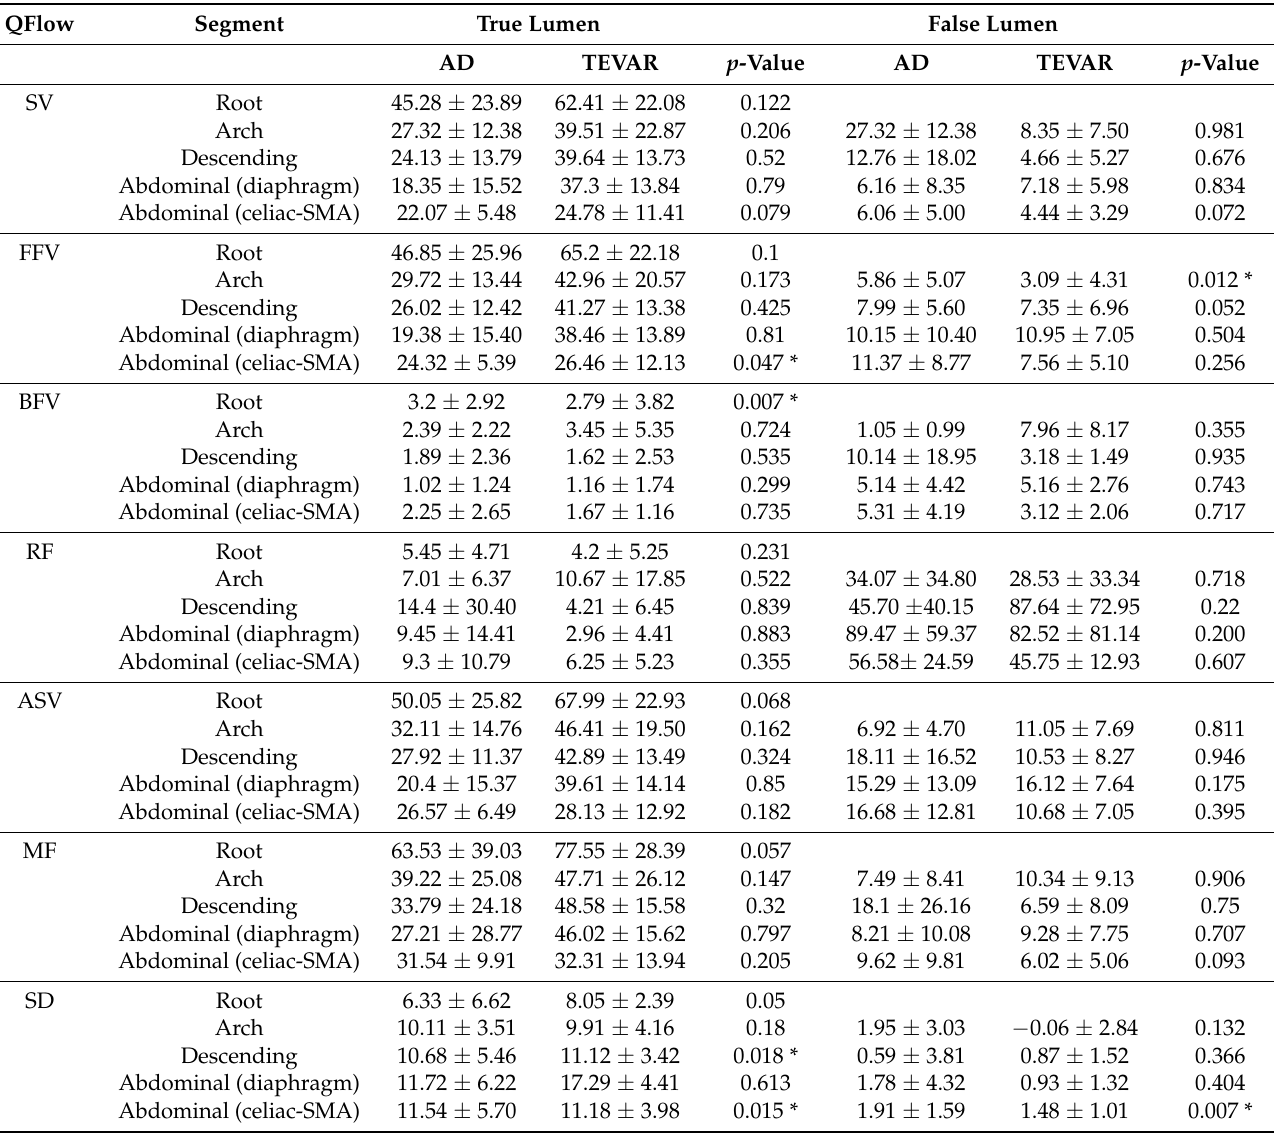
Table 2. Paired comparison of the QFlow parameters of the same 10 participants with aortic dissection before and after